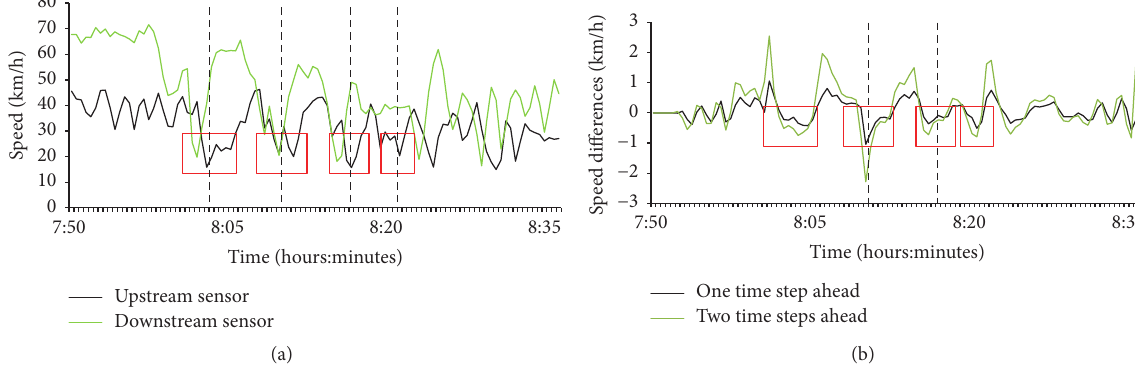
Figure 7: Detecting delay occurrences associated with shockwaves in NGSIM data using (a) the proposed algorithm and (b) benchmark algorithm [17]. Dashed vertical lines denote the time points where the algorithms detect delay occurrences. Red squares denote the duration where the occurrences of shockwaves are